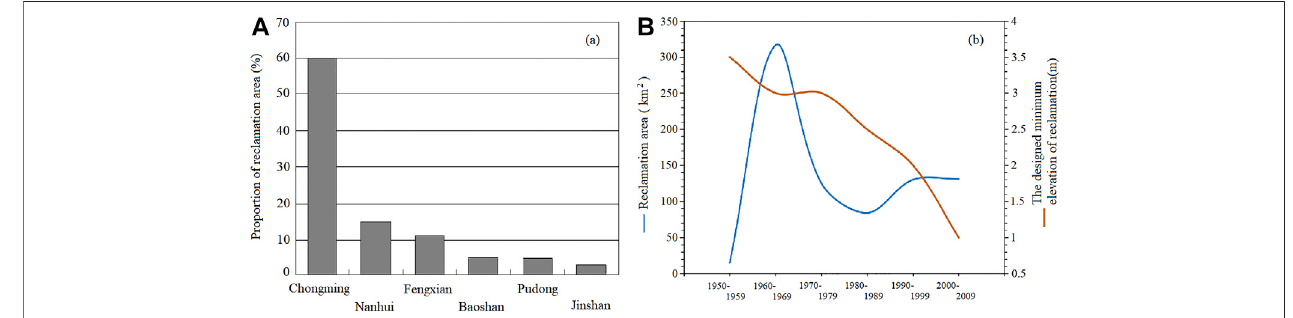
FIGURE 5 | Reclamation of Chongming Island after the mid-20th century. (A) Comparison of reclamation scale of the suburban counties of Shanghai during 1953 – 2004; (B) Historical changes of coastal wetland reclamation area changes and the designed minimum elevation of reclamation in Chongming Island. Data on reclamation were based on the Chronicles of Chongming County (Zhou, 1989), the Chronicles of Chongming County (Zhang and Zhu, 2013), and the Chongming Yearbook published by Chongming County Statistics Bureau during 1989 – 2010 (see Appendix Table A2). Nanhui District was of fi cially incorporated into Pudong New District in